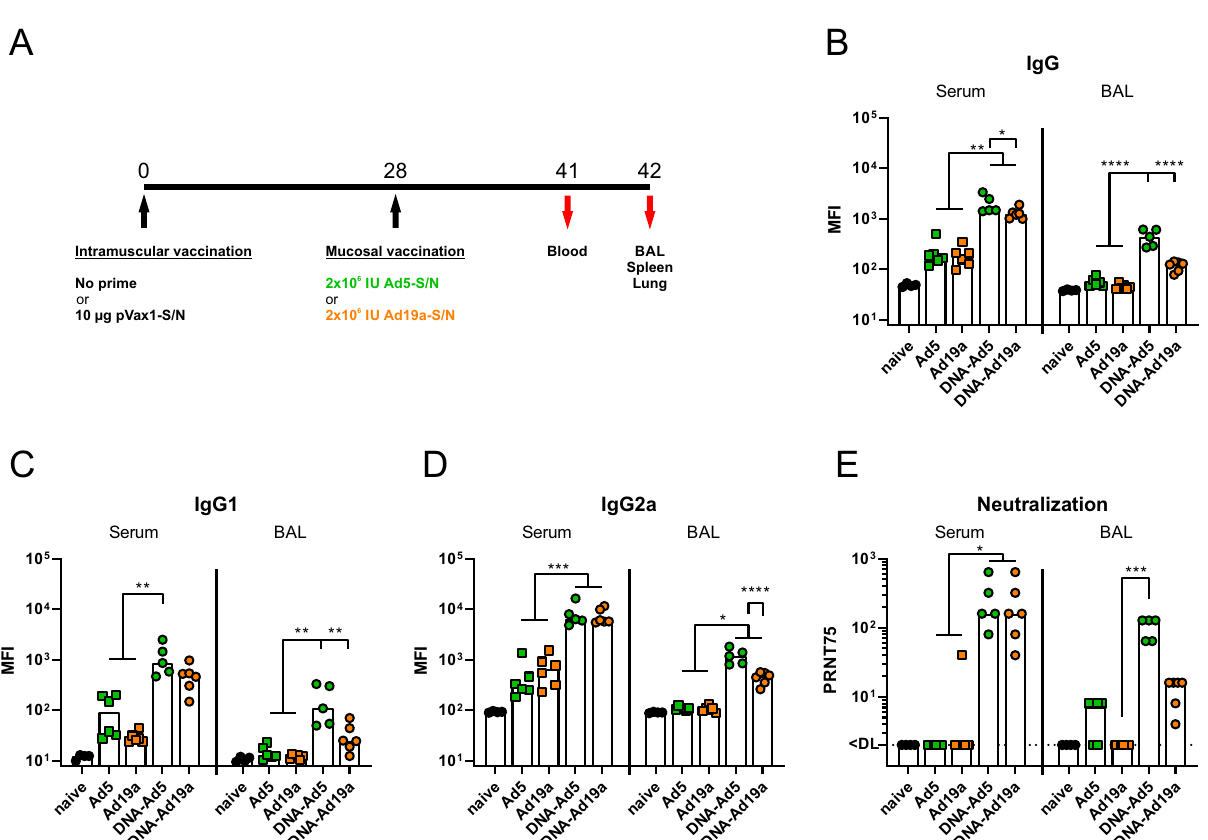
Fig. 1 Humoral responses after intranasal immunization with Ad5- or Ad19a-based viral vector vaccines. A BALB/c mice were immunized intranasally with Ad5- or Ad19a-based vectors encoding the N and S protein of SARS-CoV-2 (2 × 10 6 infectious units per vector). Mice from the heterologous prime- boost groups were primed four weeks before by intramuscular injection of N- and S-encoding DNA plasmids (10 µ g per plasmid) followed by electroporation. Serum antibody responses were analysed thirteen days and mucosal immune responses in the BALs fourteen days after the mucosal immunization. Spike-speci fi c IgG ( B ), IgG1 ( C ), and IgG2a ( D ) were assessed by a fl ow cytometric approach (dilutions: sera 1:400, BAL 1:100). Plaque reduction neutralization titres (PRNT75) were determined by in vitro neutralization assays ( E ). Bars represent group medians overlaid with individual data points; naïve n = 4; DNA-Ad5 n = 5; other groups n = 6. Data were analysed by one-way ANOVA followed by Tukey ’ s post test ( B – D ) or by Kruskal – Wallis test (one-way ANOVA) followed by Dunn ’ s multiple comparison test ( E ). Statistically signi fi cant differences are indicated only among the different vaccine groups; p values indicate signi fi cant differences (* p < 0.05; ** p < 0.005; *** p < 0.0005; **** p <